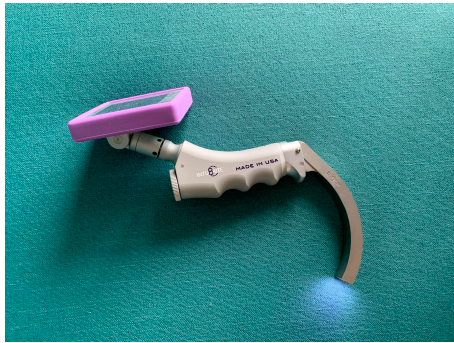
Figure 2. Intubrite videolaryngoscope (author’s own material).